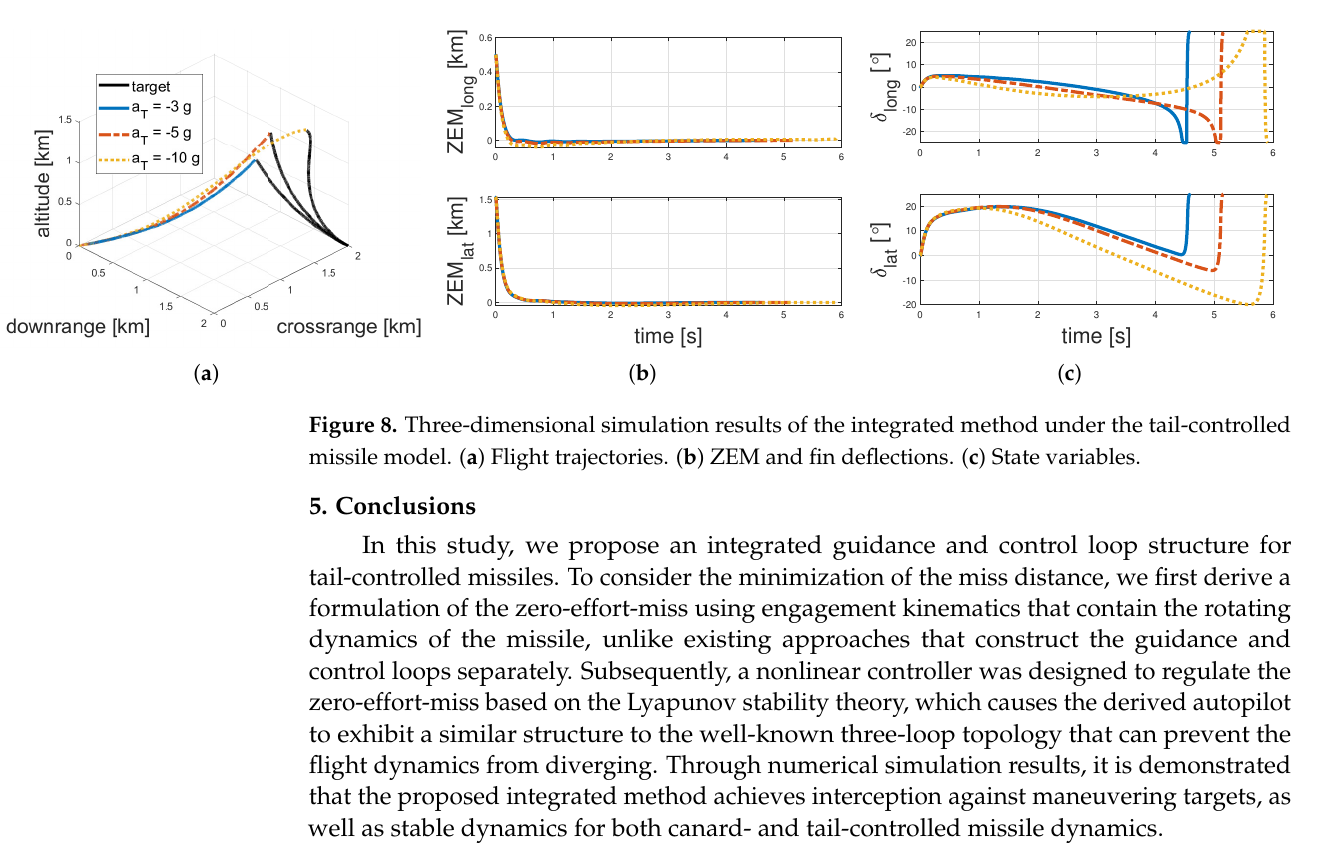
Figure 7. Three-dimensional simulation results of the integrated method under the canard-controlled missile model. ( a ) Flight trajectories. ( b ) ZEM and fin deflections. ( c ) State variables.